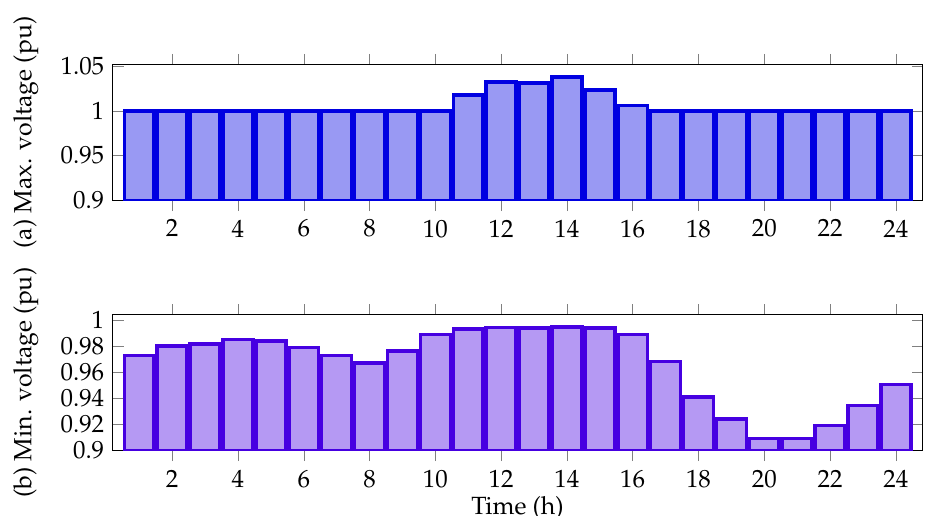
Figure 9. Voltage behavior during one day in the 69-node test system: ( a ) maximum voltage and ( b ) minimum